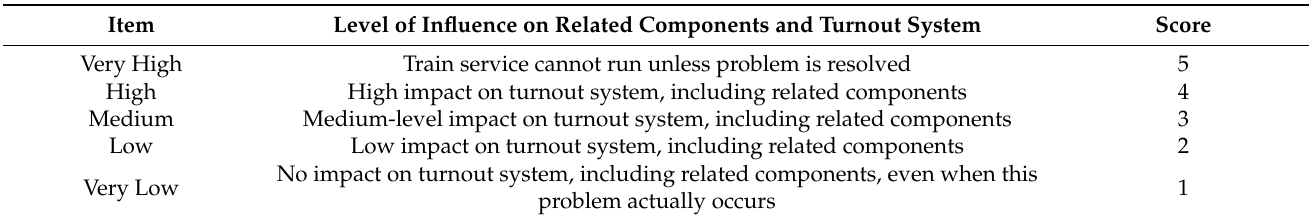
Table 3. Impact score criteria.